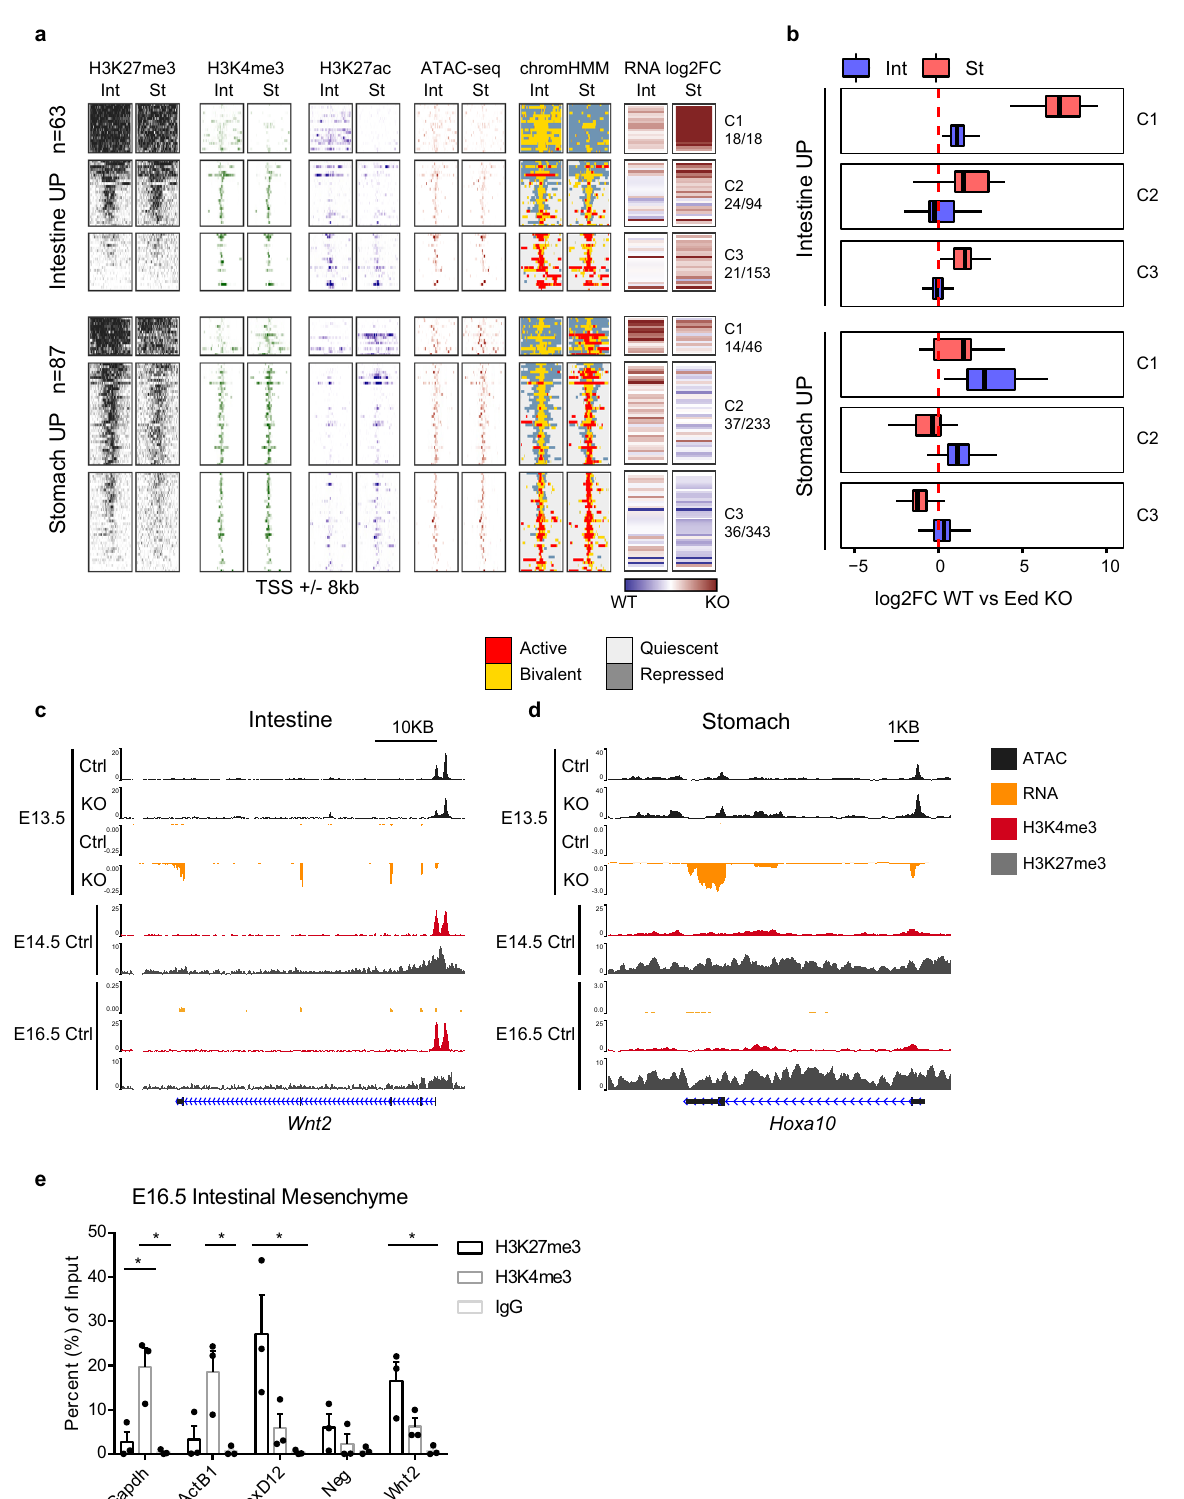
Pdgfr β Cre-ERT2/+ ; Eed fl / fl and Pdgfr β +/+ ; Eed fl / fl mice were sacri fi ced and analyzed. Pdgfr β Cre-ERT2/+ ; Eed fl / fl + mice demonstrated a signi fi cant increase in crypt length ( p < 0.001) relative to CRE-negative